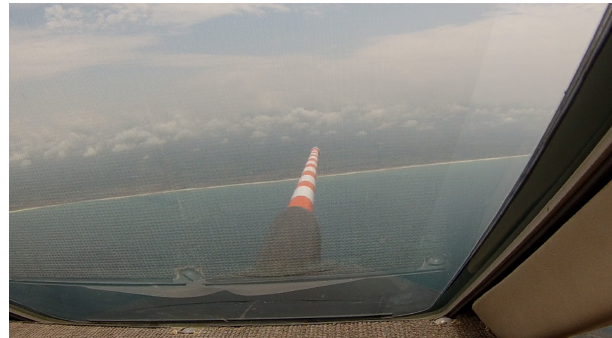
Figure A2. Image from the cockpit of the Falcon-20 operated by the DLR for the flight conducted on 5 July 2016 at 11:35UTC taken in front of the shore of the Gulf of Guinea (at 6.4 ◦ N, 1.6 ◦ E,